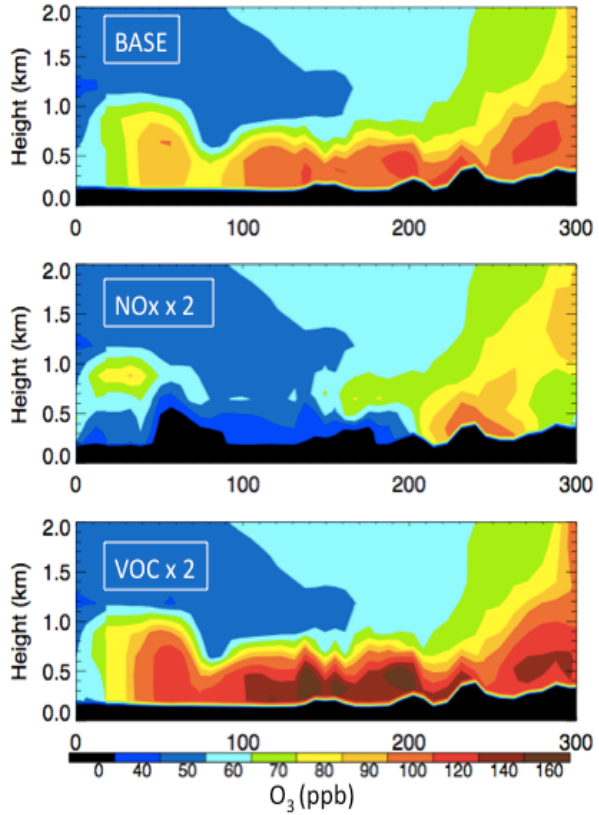
Fig. 11. The calculated cross section (altitude–downwind distances) of the city plumes of O 3 on 12 September, due to different emis- sions, such as the base model run (upper panel), doubled NO x emis- sions (middle panel), and doubled VOC emissions (lower